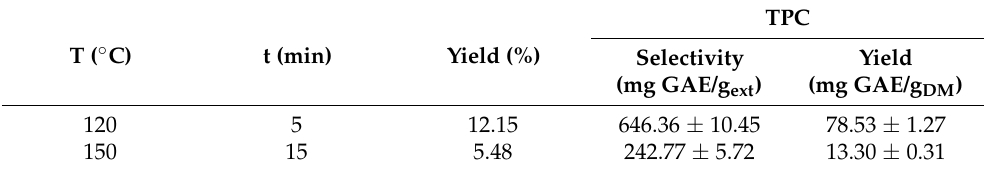
Table 2. Extraction conditions, yield, and TPC of the sample obtained with the process performed at 120 ◦ C and 150 ◦ C.